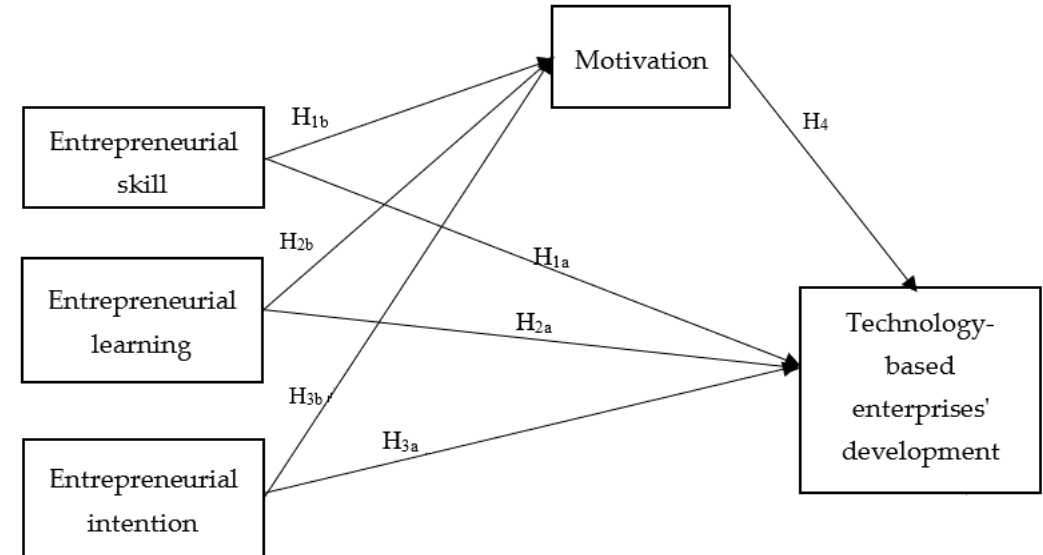
Figure 1. Conceptual framework (source: self-elaborated by the authors).